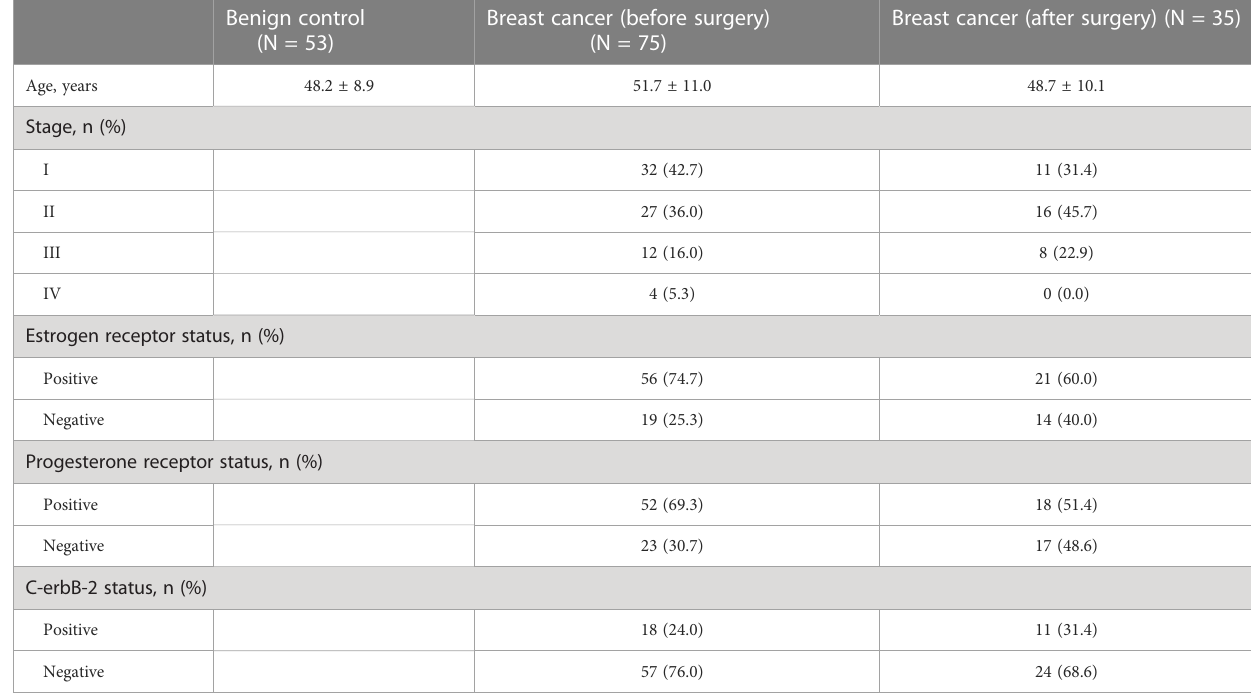
TABLE 1 Basic characteristics of the participants included in the